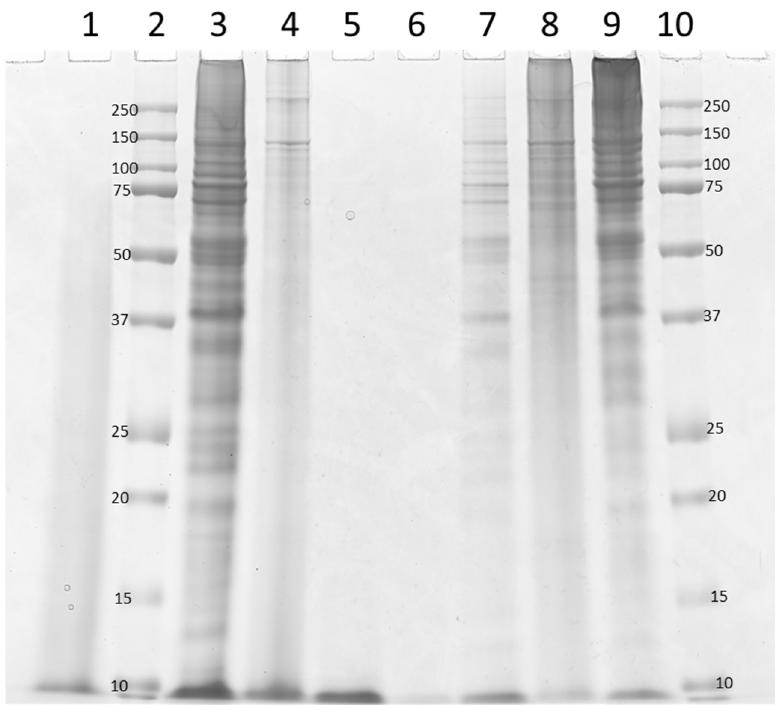
Figure 2. Hydrolysates resulting from Bromelain (-B) and Endocut-02 (-E) hydrolysis on four different raw materials, and Mw marker (sizes given in the figure), run on a 12% SDS-PAGE gel. From left to right: (1) TCT+CM-B, (2) Mw marker, (3) TCT+CM-E, (4) MDCR-B, (5) CM-E, (6) CM-B, (7) MDCR-E, (8) TCT-B, (9) TCT-E, (10) Mw marker.